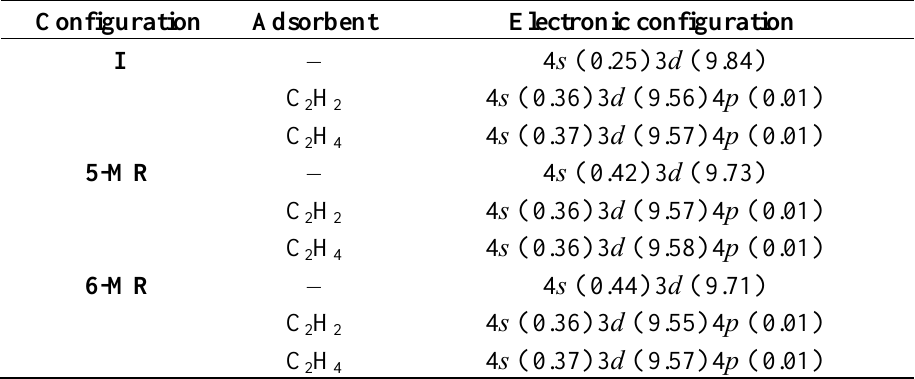
Table 3. Electronic configurations of Cu–ZSM-5 before and after the binding of an unsaturated hydrocarbon, based on natural atomic orbital analyses